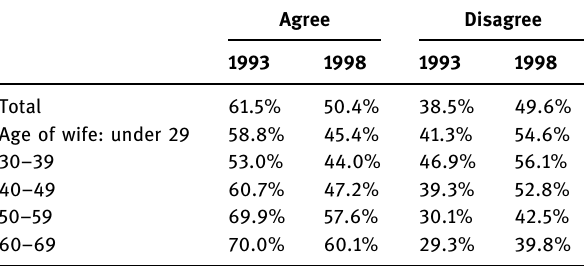
Table 2: Women ’ s opinions on “ Aged parents should live with their son ’ s family ” ( Cabinet O ffi ce, Opinion Poll for People ’ s Lives )